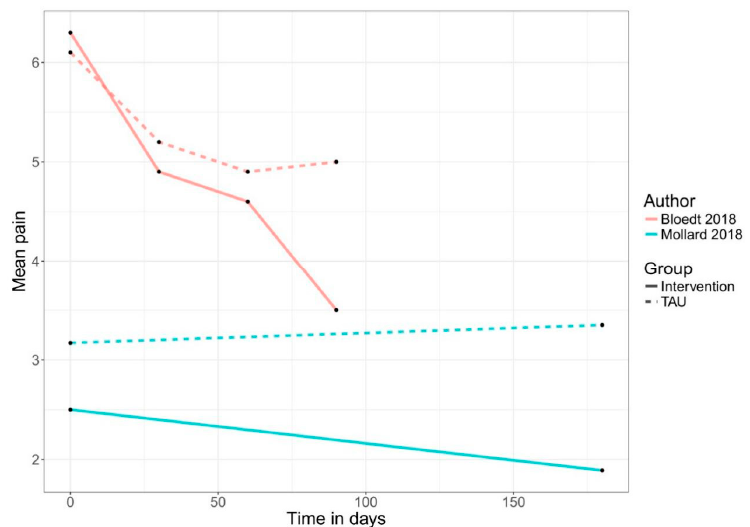
Figure 5. Improvement in pain over time in group comparison. Abbreviations: TAU = treatment as usual.